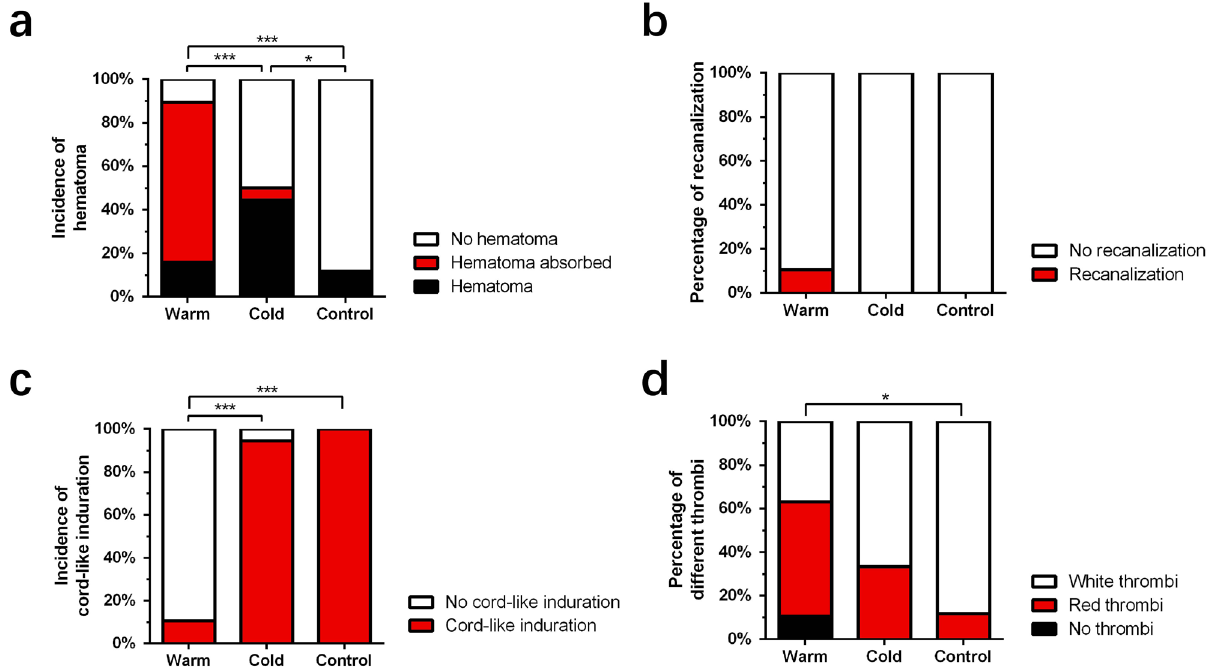
Figure 5. Changes in three groups at 1 day after intravascular injection. ( a ) Incidence of hematoma in different groups 1 day after intravascular injection. ( b ) Percentage of vascular recanalization in different groups 1 day after intravascular injection. ( c ) Incidence of cord-like induration in different groups 1 day after intravascular injection. ( d ) Percentage of different embolisms in different groups 1 day after intravascular injection. *P < 0.05; ***P < 0.000. Figure was created in Adobe Illustrator software (version 22.1; https:// www. adobe. com/ produ cts/ illus trator. html) and GraphPad Prism software (version 9.4.1; https:// www. graph pad. com/ scien tific- softw are/ prism/).